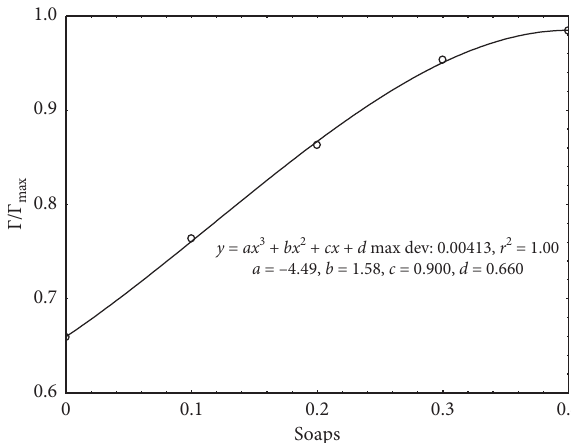
Figure 15: Variation of ( Γ / Γ